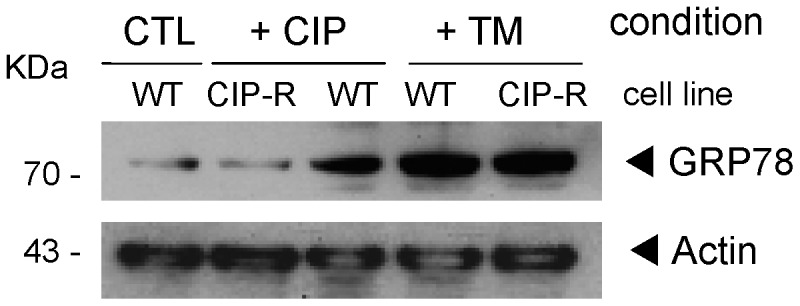
ER stress response evaluation.Immunoblot of Grp78 and actin as loading control in whole cell lysates from cells growing in standard conditions (line 1, WT cells in control medium; line 2, CIP-R cells in medium added by 0.2 mM ciprofloxacin), or in WT cells exposed for 24 h to 0.2 mM ciprofloxacin (line 3), or in cells exposed for 24 h to 0.5 µg/ml tunicamycin (TM; line 4, WT cells; line 5, CIP-R cells). The anti-Grp78 is a rabbit antiserum used at 1∶500 dilution. The hatched square highlights the standard conditions of culture for each cell line.